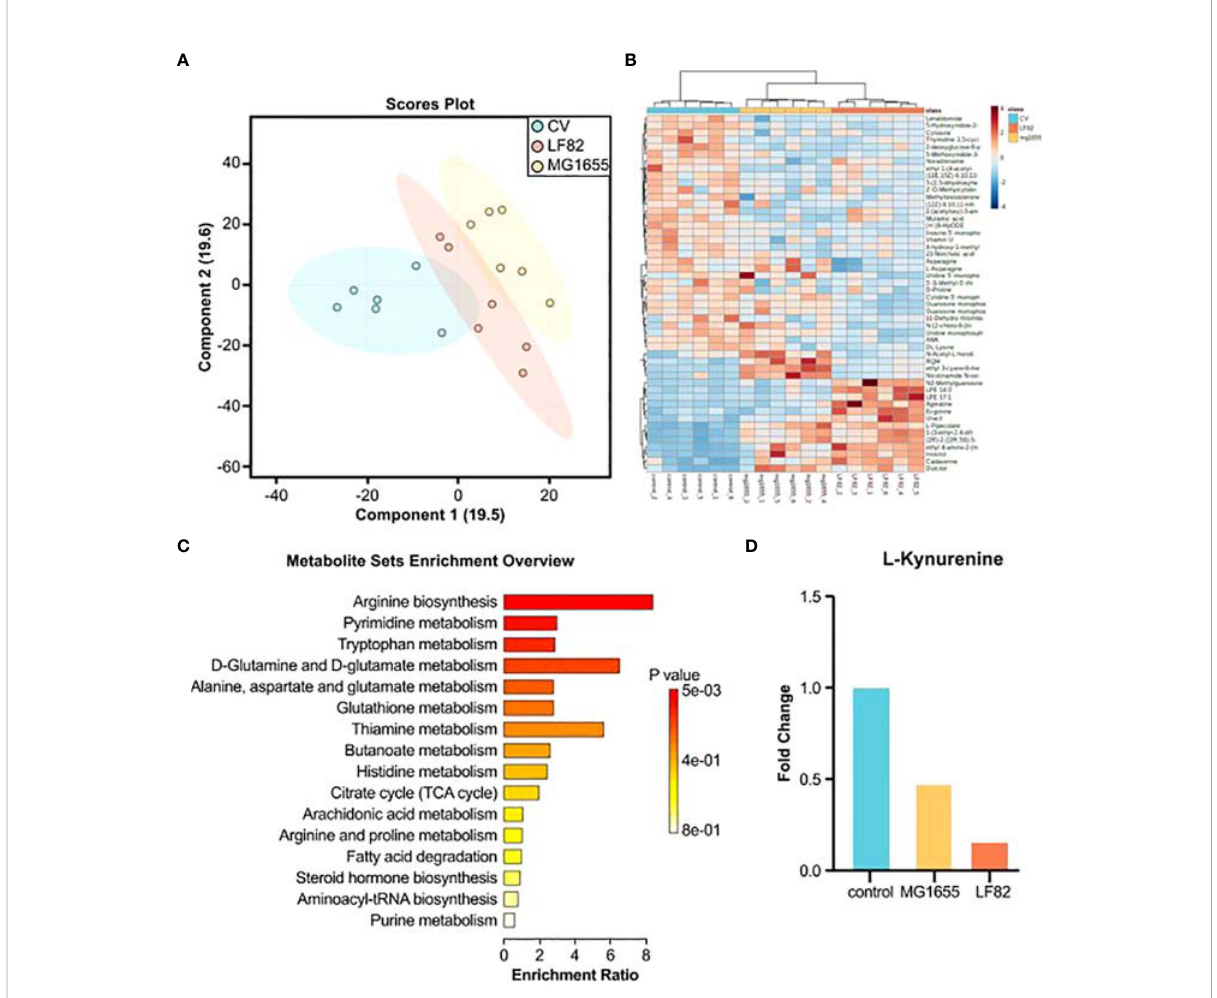
FIGURE 4 LF82 impacts gut metabolites in the honeybee gut. (A) Sparse partial least squares discriminant analysis (PLS-DA) based on all metabolites detected in the gut of honeybees. (B) Unsupervised hierarchical clustering heatmap of the 50 metabolites that contribute most to the separation of different groups in the gut samples. (C) Down-regulated metabolite KEGG enrichment pathway in the LF82 group. (D) The levels of L- kynurenine in each